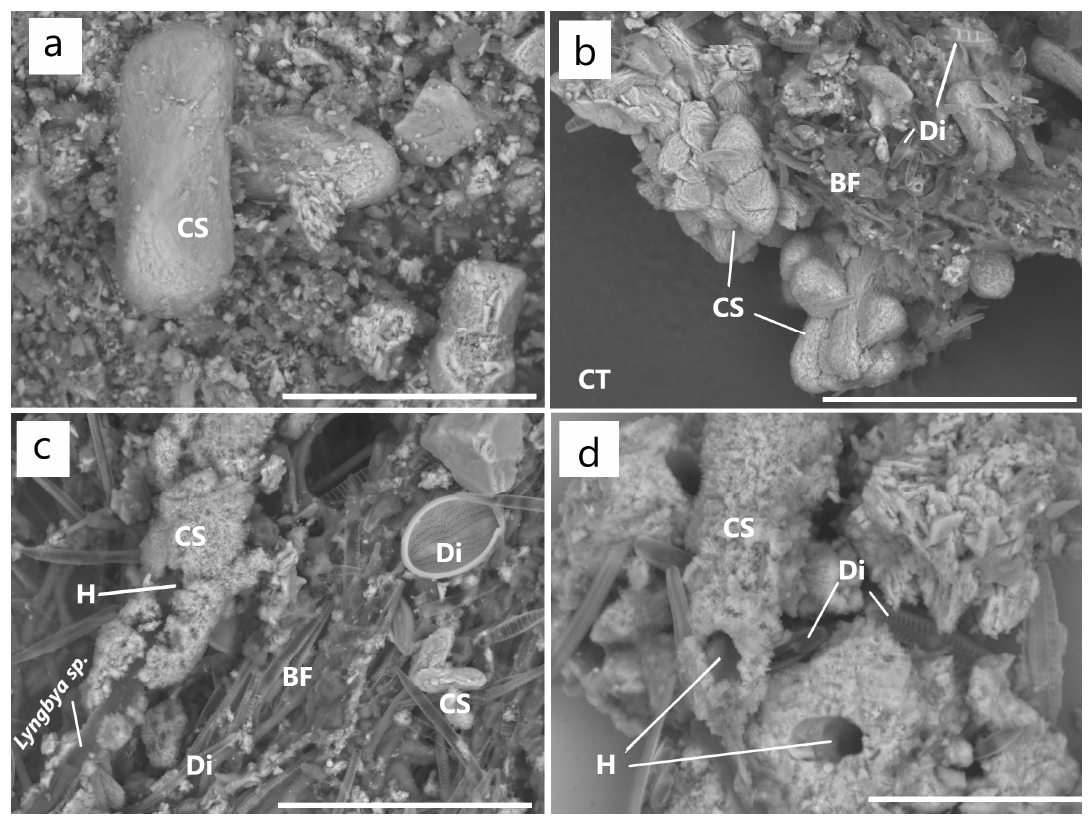
Figure 8. SEM images of calcite sediments formed in 6-month experiments: ( a )—single calcite formation with spirally wrapped shape, scale bar 50 μ m; ( b )—splices 30–45 μ m long of dumbbell-shaped crystals, scale bar 50 μ m; ( c )—calcite covers around the Lyngbya sp. (formation of intergrowths of acicular crystals) and dumbbell-shaped crystals, scale bar 50 μ m; ( d )—thick calcite covers (~15 μ m) around the Lyngbya sp. similar to a natural sample (Figure 7b); scale bar 30 μ m.